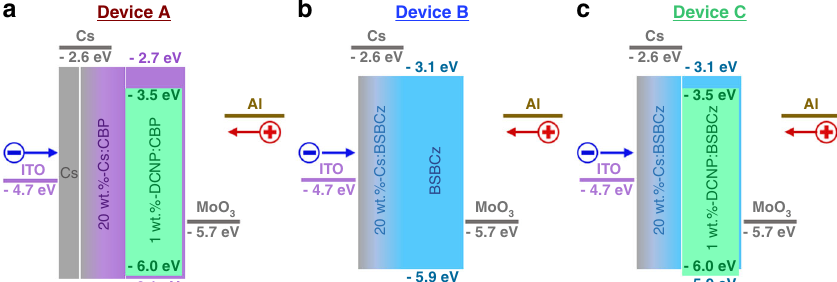
Fig. 3 Energy level diagrams of the OLEDs. EML consist with a 1 wt.%-DCNP:CBP (device A), b pristine BSBCz (device B), and c 1 wt.%-DCNP:BSBCz (device C) which were used to compare triplet accumulation property of CBP versus triplet scavenging property of BSBCz.